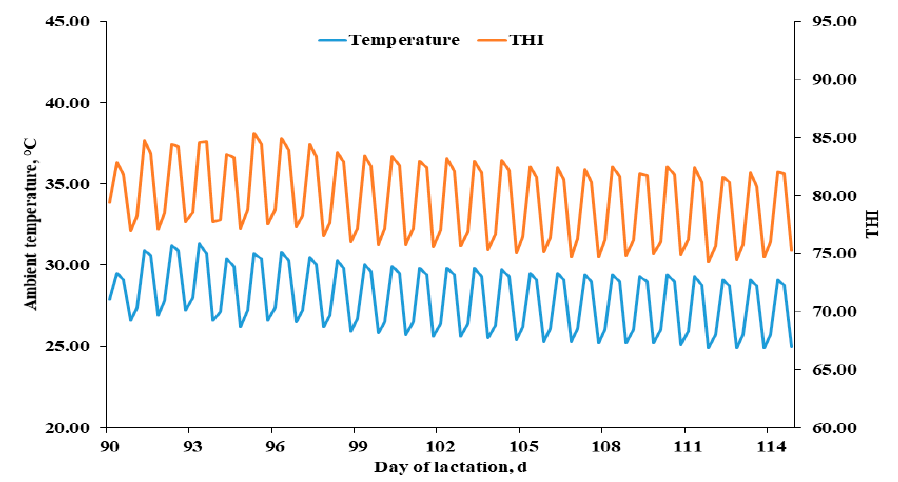
Figure 8. Ambient temperature (blue line) and temperature-humidity index (THI; orange line) during experimental period.